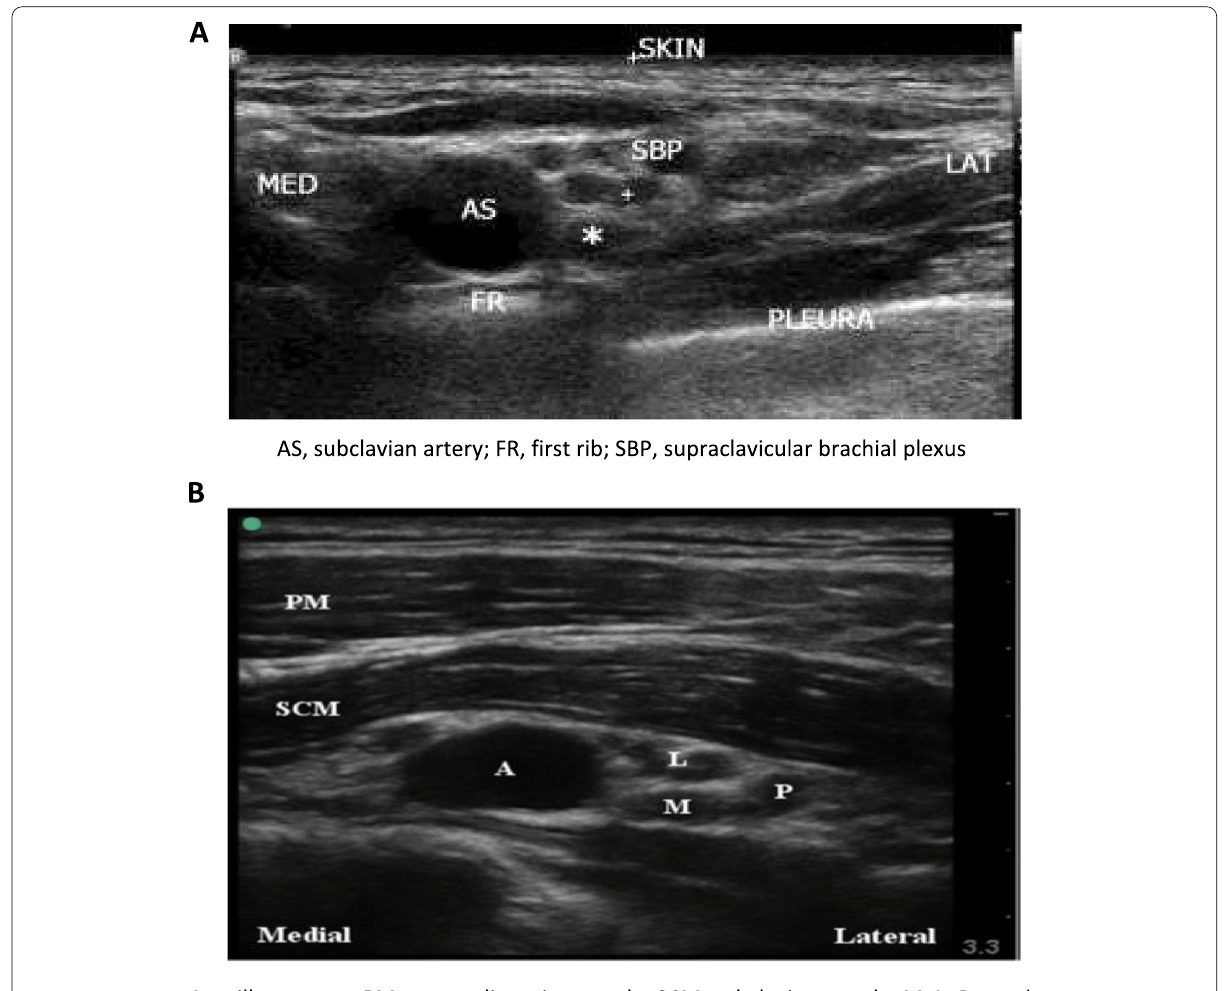
Fig. 1 A Ultrasonography image for Supraclavicular brachial plexus block (SC-BPB). Brachial plexus is seen as hypoechoic nodules lateral to the subclavian artery. B Ultrasonography image for Infraclavicular brachial plexus block (IC-BPB). Brachial plexus is seen as hypoechoic nodules lateral